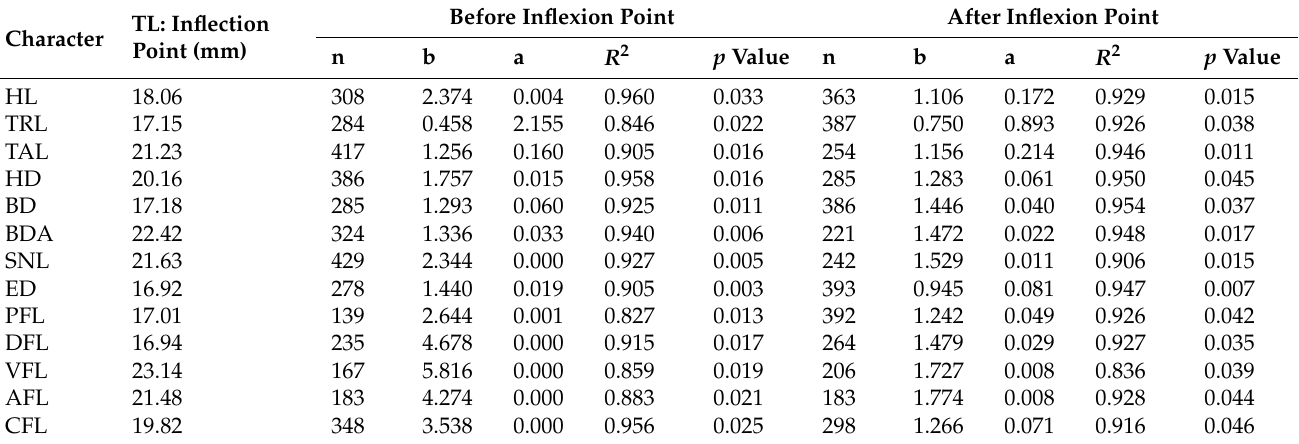
Table 2. Regression parameters for allometric growth of P. retrodorslis